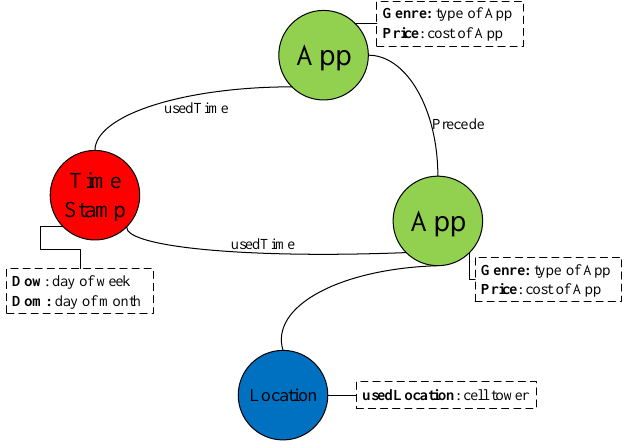
Figure 2. An example attributed heterogeneous network for App usage